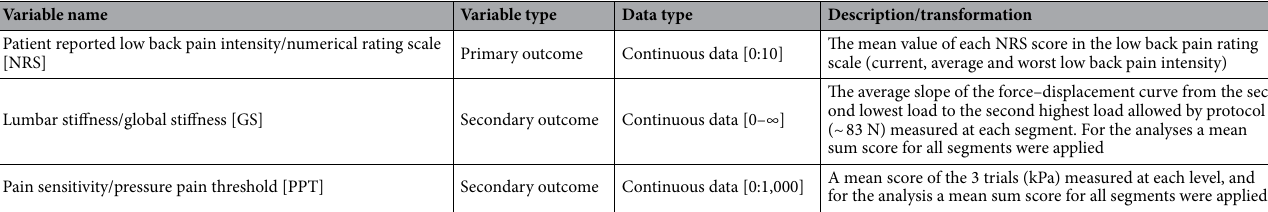
Table 1. An overview of the variables of interest for the